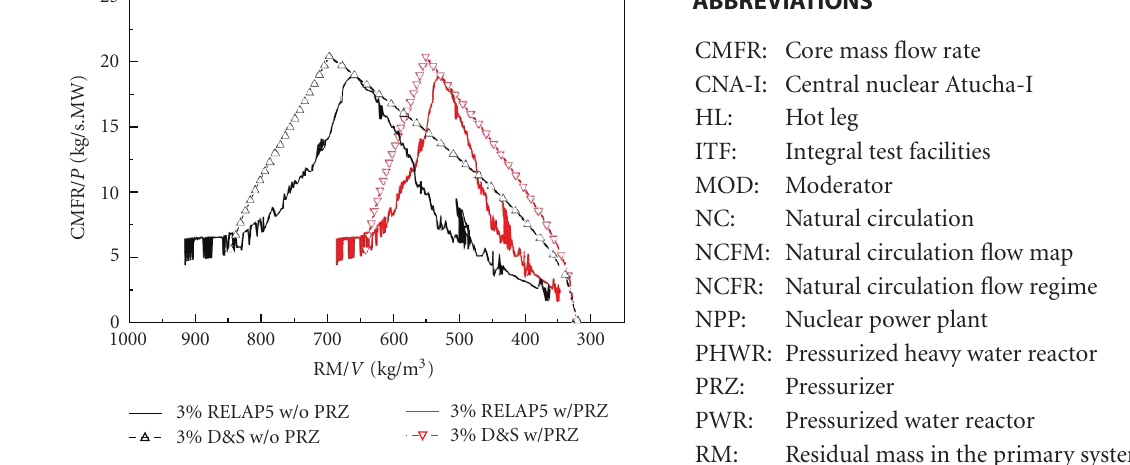
Figure 12: The e ff ect of PRZ volume on the NCFM.